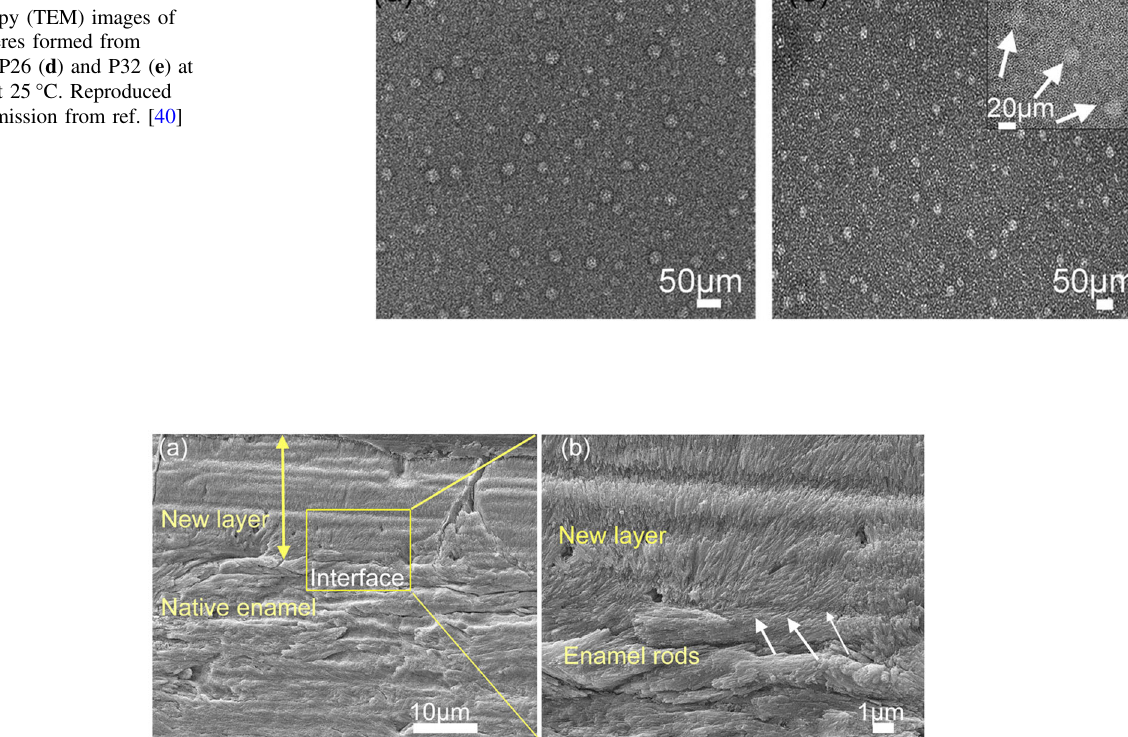
Fig. 4 Transmission electron microscopy (TEM) images of nanospheres formed from peptides P26 ( d ) and P32 ( e ) at pH 7.4 at 25 °C. Reproduced with permission from ref. [40]